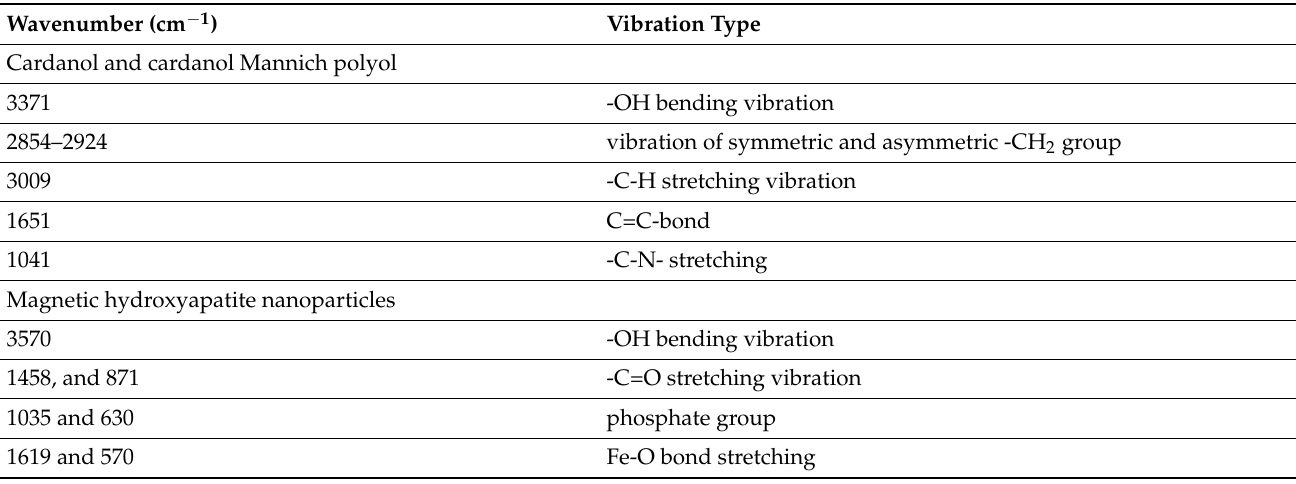
Table 2. Peaks observed in FT-IR spectra of cardanol and cardanol Mannich polyol and magnetic hydroxyapatite nanoparticles and the corresponding functional groups.